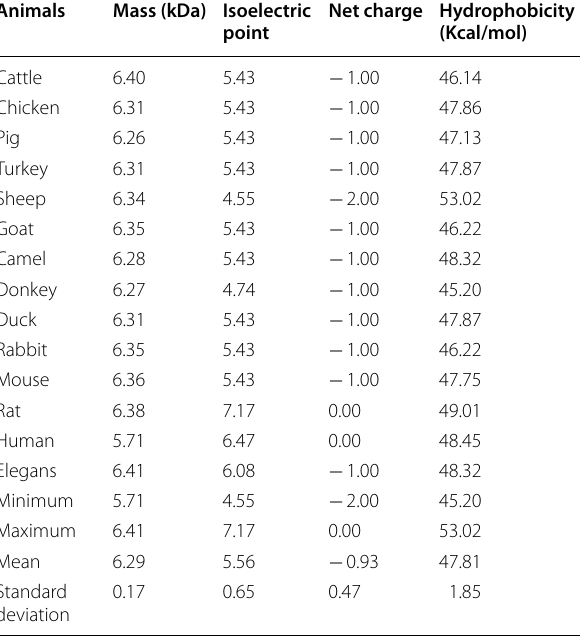
Table 4 The physicochemical properties of the amino acid sequences of HSP70 of the selected